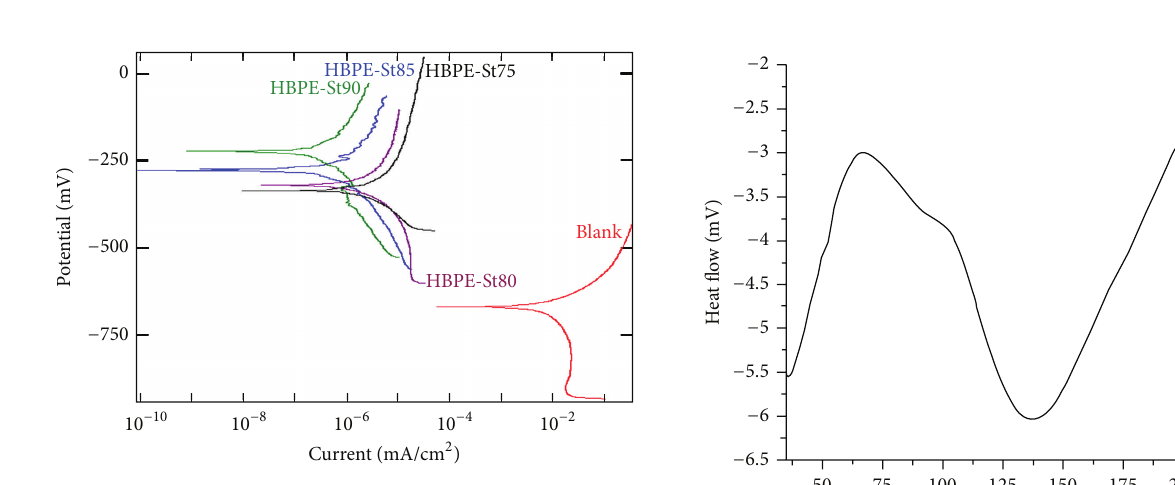
Figure10:TafelplotsofblankandcoatedwithHBPE-Stintapwater.